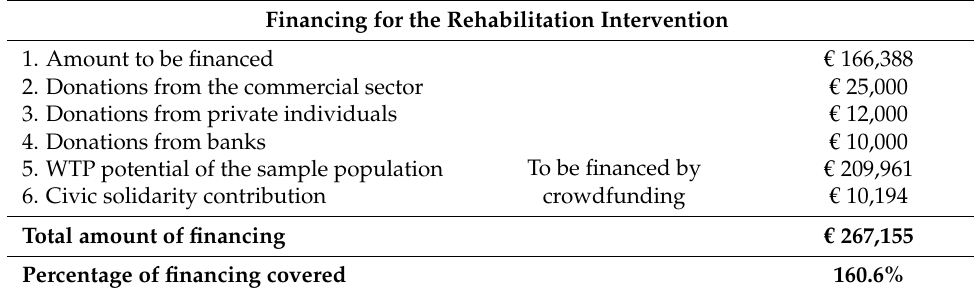
Table 6. The mix of funding sources for the rehabilitation of the residual area. Financing for the Rehabilitation